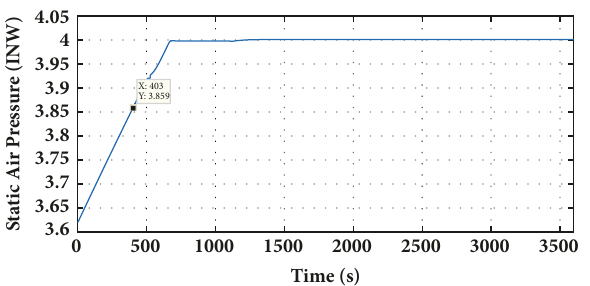
Figure 24: Static pressure P s response.